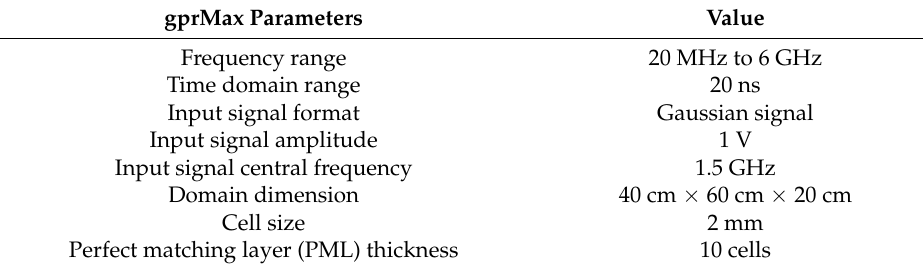
Table 1. Summary of the key simulation parameters